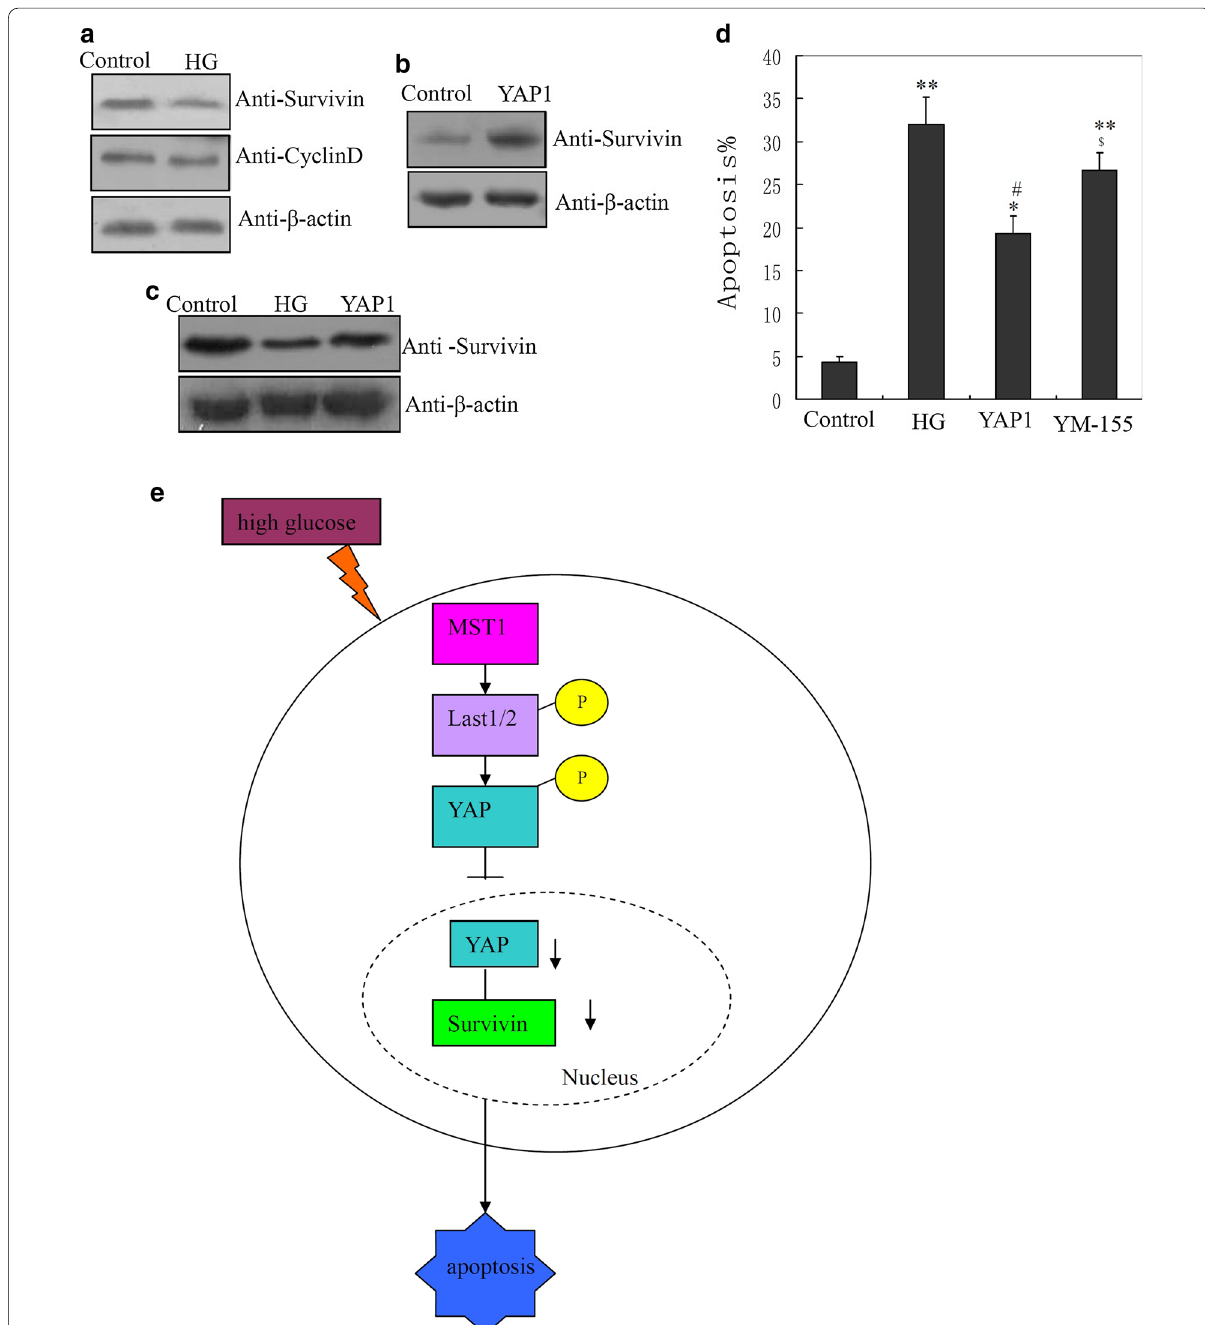
Fig. 6 Survivin targeted by yes-associated protein 1 (YAP1) in response to high glucose (HG) in cardiomyocytes. Western blotting showing: a Survivin and CyclinD1 protein expression in cardiomyocytes after 2 days of HG treatment (experiments were replicated 3 times); effect of YAP1 overexpression on b upregulation of Survivin protein (n 3) and c suppression of HG-mediated downregulation of Survivin (n 3). d Hoechst = = 33,342 staining showing inhibitory effect of YM155 on the capacity of YAP1 to suppress HG-induced apoptosis; *P < 0.05 and **P < 0.01 compared 3); $ P < 0.05 and $$ P < 0.01 compared with the YAP1 with the untreated group; # P < 0.05 and ## P < 0.01 compared with the HG-treated group (n = plasmid-transfected group. e Sketch diagram showing the regulatory mechanism of the mammalian sterile 20-like kinase 1 (MST1)/large tumor suppressor kinase 1 and 2 (LATS1/2)/YAP1/Survivin pathway in modulating cardiomyocyte apoptosis and maternal diabetes-induced heart